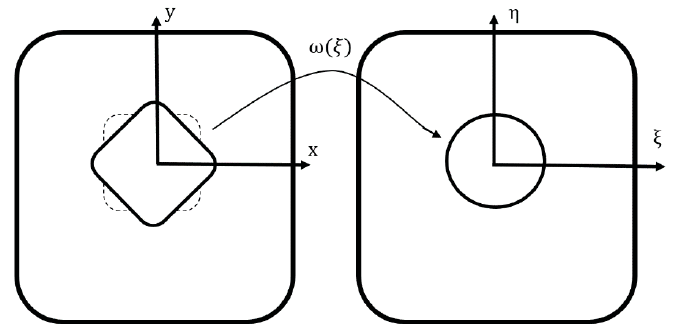
Figure 3. Mapping a plate containing quasi-square cut out to a plate containing a circular cut